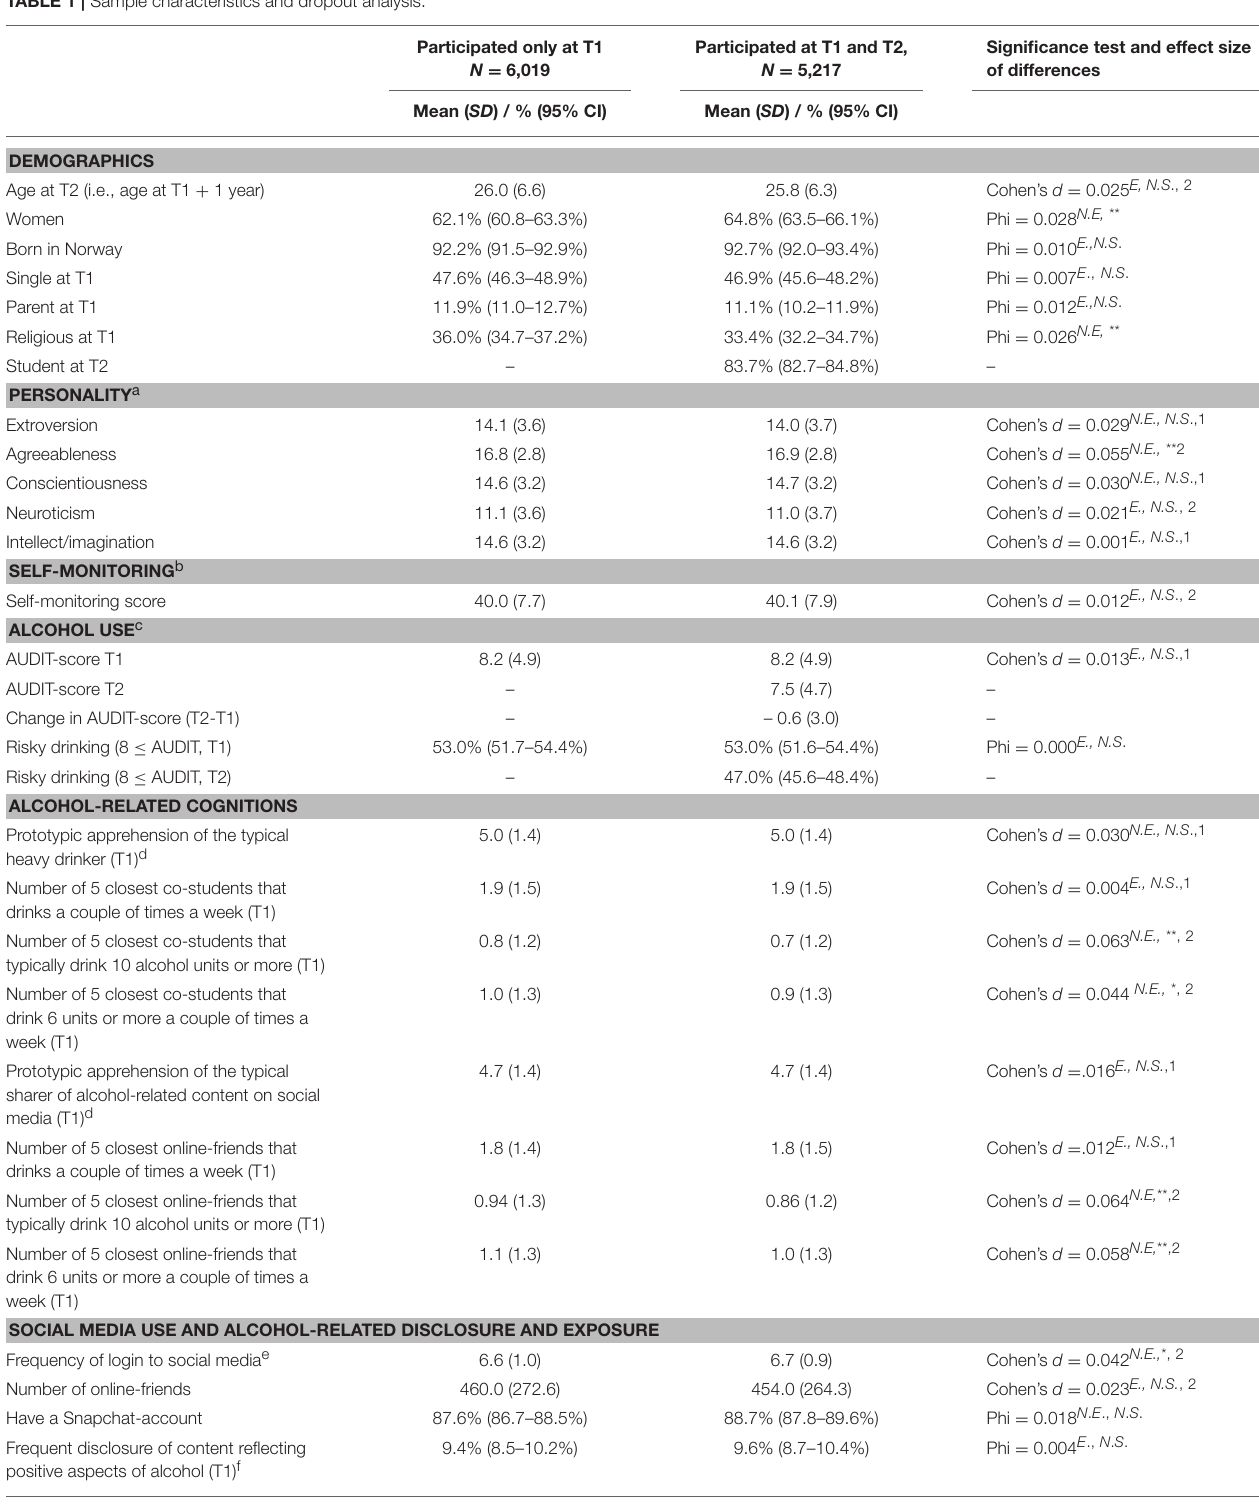
TABLE 1 | Sample characteristics and dropout analysis.